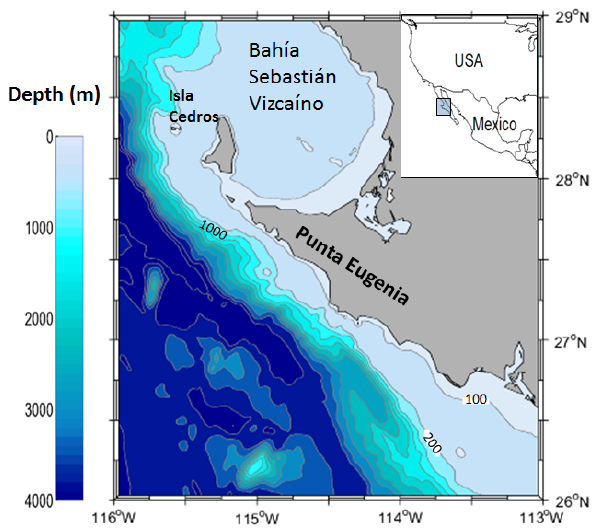
Fig. 1. Location and bathymetry characteristics of the study